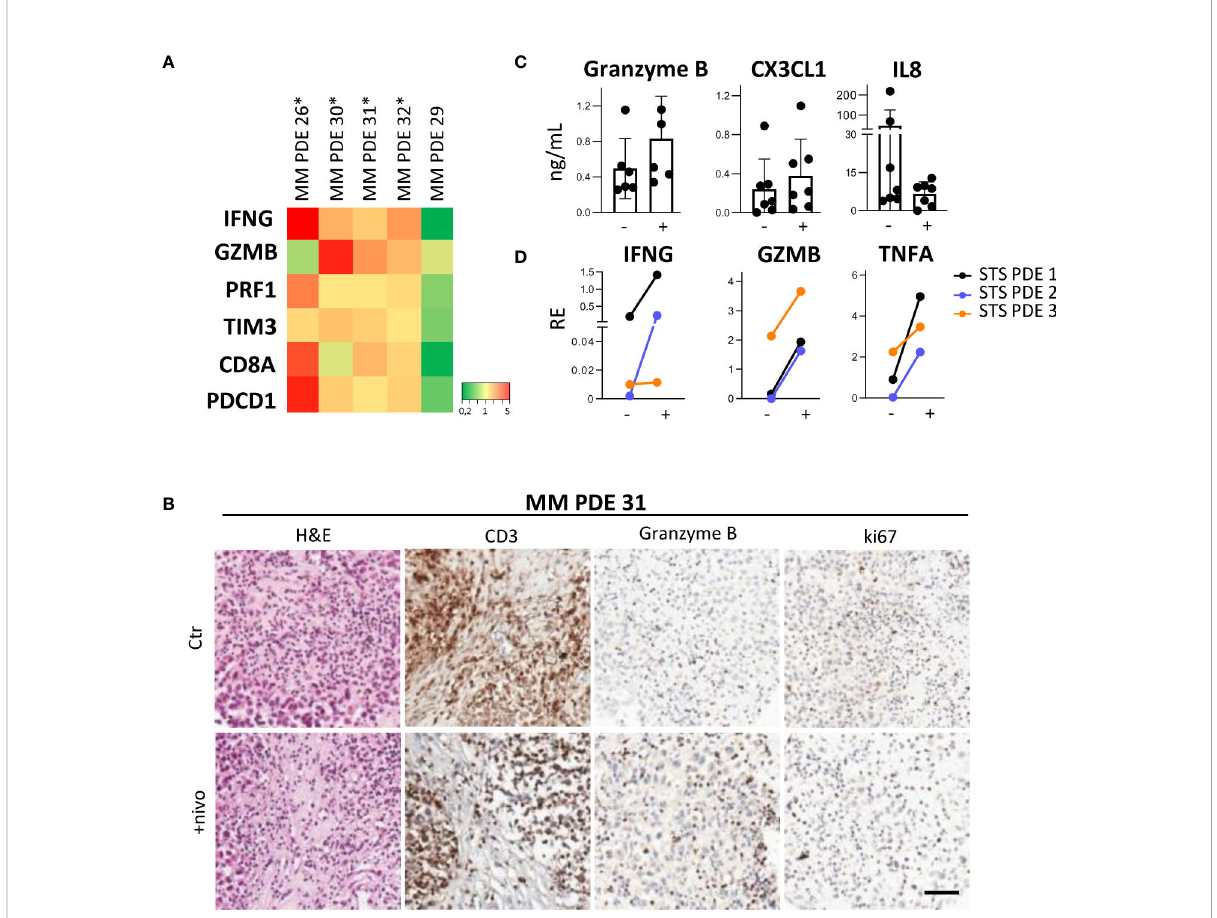
FIGURE 2 Ex-vivo treatment with nivolumab of 3D PDE in RCCS Bioreactor. (A) Heatmap showing gene expression levels in MM PDE deriving from lymph node metastases of treatment-naïve melanoma patients. Ratio of PDE treated with nivolumab and untreated control, p=0.013 by MANOVA. *: patients responding to adjuvant immunotherapy (absence of relapse at one year). (B) IHC staining of CD3, Granzyme B and ki67 in a representative case of MM PDE. Ctr: Control; +nivo: +nivolumab. (C) Granzyme B, CX3CL1 and IL8 in culture supernatants from MM PDE. (D) Expression of IFNG, Granzyme